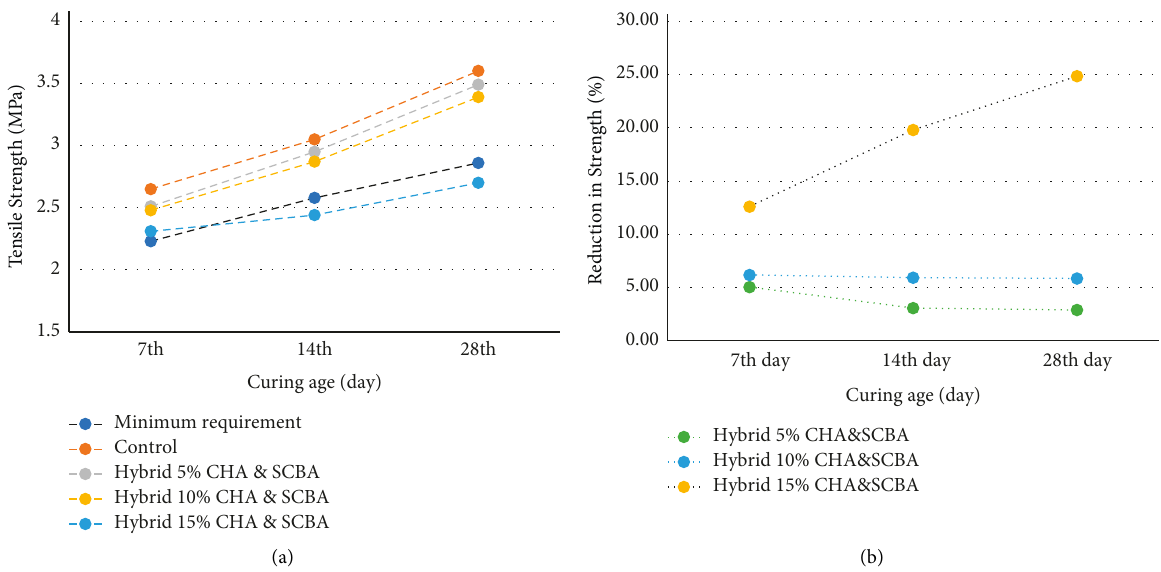
Figure 10: (a) Split tensile strength of test specimens and (b) reduction in tensile strength of partially replaced cement concerning control specimen.